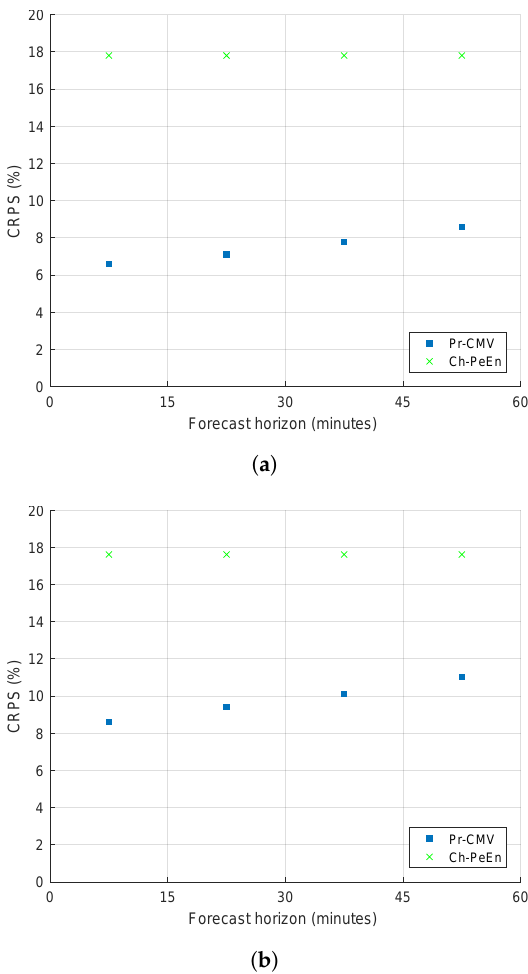
Figure 5. CRPS of the probabilistic forecast models CH-PeEn and Pr-CMV for the two sites, Carpen- tras ( a ) and Signes ( b